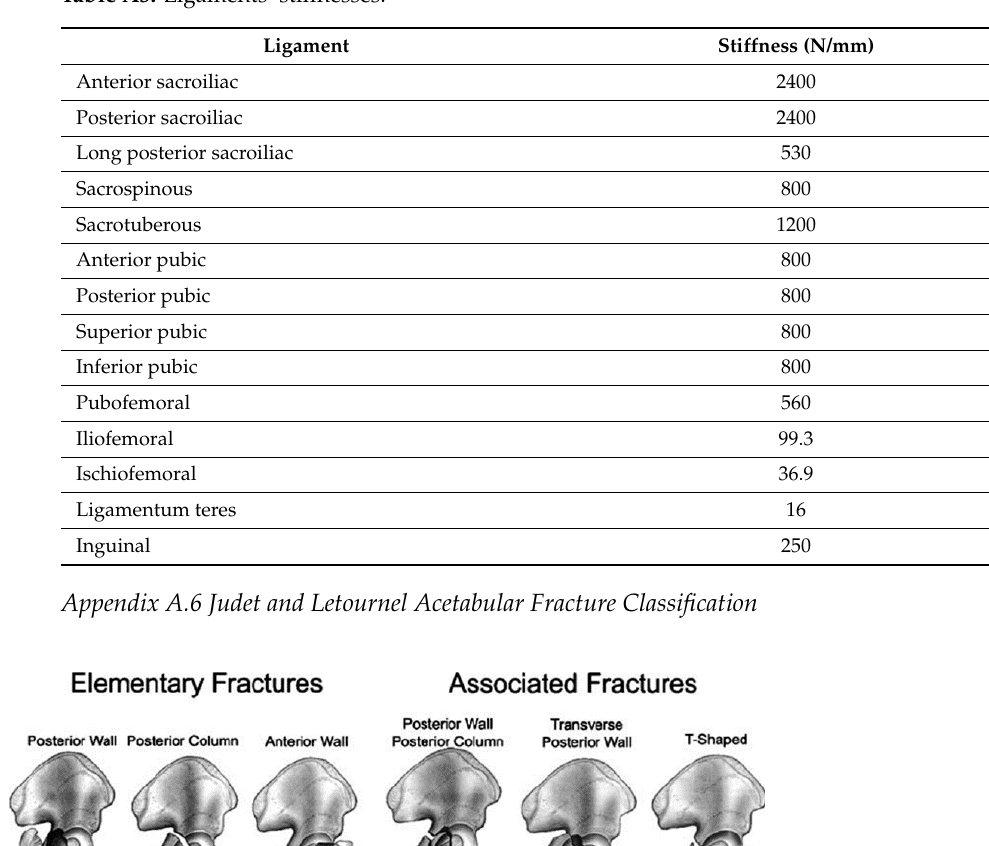
Table A3. Ligaments’ stiffnesses.